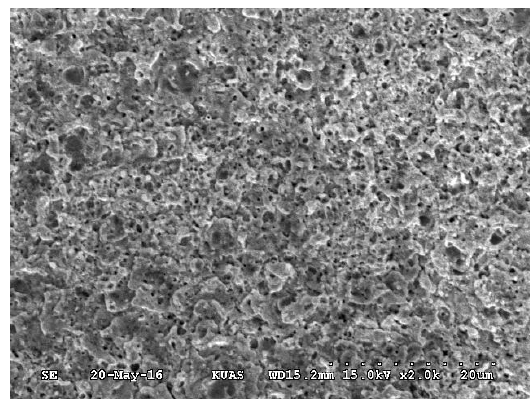
Figure 7. Surface appearance for processing time 15 s and an AgNO 3 concentration of 0.09 wt.%.